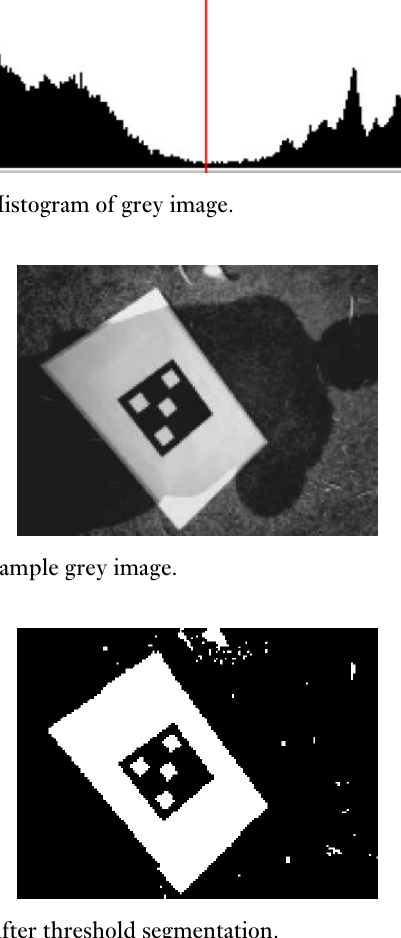
Figure 5 After threshold segmentation.